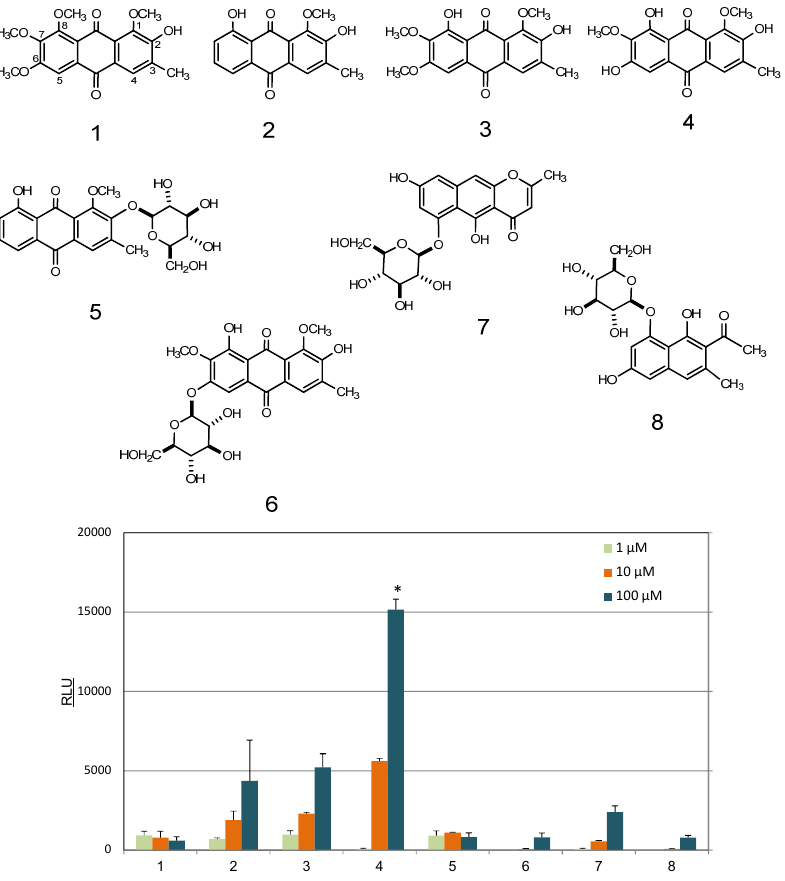
Figure 3. Induction of luciferase activity in the CALUX assay of compounds isolated from cassia seeds. 1 , chryso-obtusin; 2 . obtusifolin; 3 . obtusin; 4 . aurantio-obtusin; 5 . obtusin 2- O -glucoside; 6 . aurantio-obtusin 6- O -glucoside; 7 . nor-rubrofusarin 6- O -glucoside; 8 . 6-hydroxymusizin 8- O -glucoside. * p < 0.05 vs.